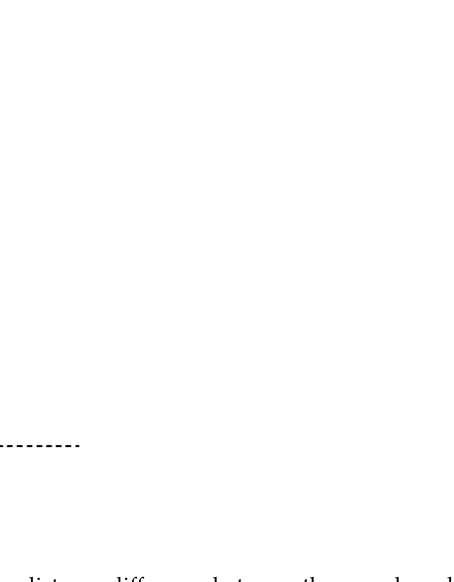
Figure 11. Schematic representation of the distance difference between the sound reaching the ears. The distance difference can be expressed as a function of the azimuth φ